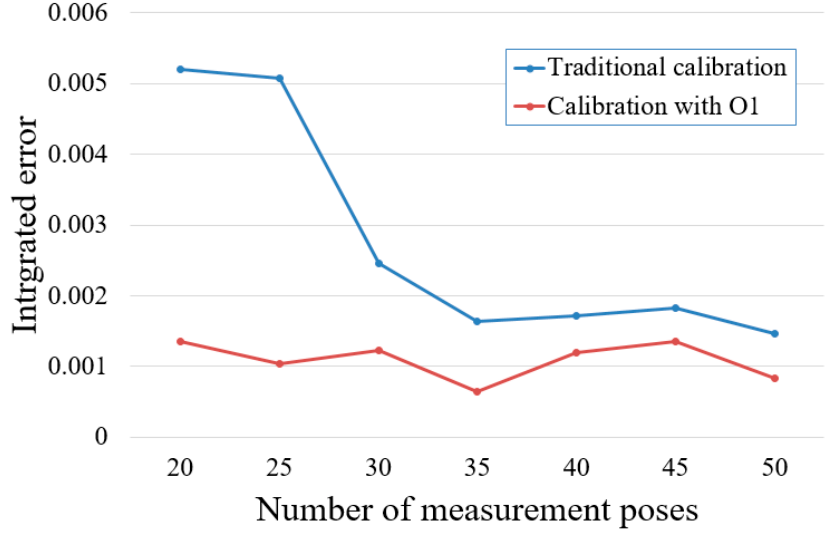
Figure 10. Relationship between integrated error and number of measured poses.